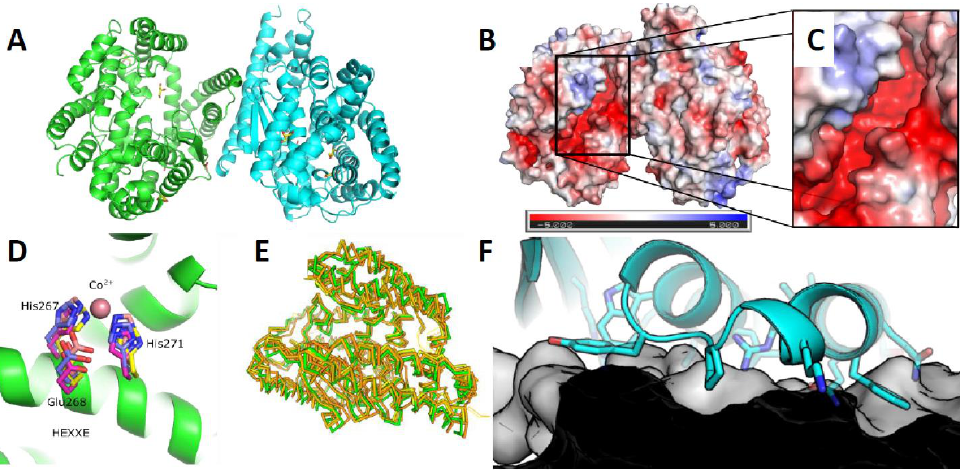
Figure 4. Crystal structure of ChtCP carboxypeptidase from Chitinophaga sp. ( A ): The crystal structure of the carboxypeptidase ChtCP. The protein forms a dimer in the crystals structure which is believed to be the active form. ( B ) The electrostatic potential surface calculated from the crystal structure of ChtCP. The surface is contoured from −5 to +5. ( C ): A zoomed in view of the negatively charged active site groove of ChtCP. ( D ): The highly conserved metal binding residues of ChtCP aligned to the closely related structures PDB: 3HOA and 3HQ2. ( E ): ChtCP aligned to the 5 most closely related protein structures in the PDB (5GIV, 5WVU, 1WGZ, 5WVU and 3HOA) calculated by the Dali server [72] ( F ): The flat interface dimer between the 2 monomers of ChtCP.